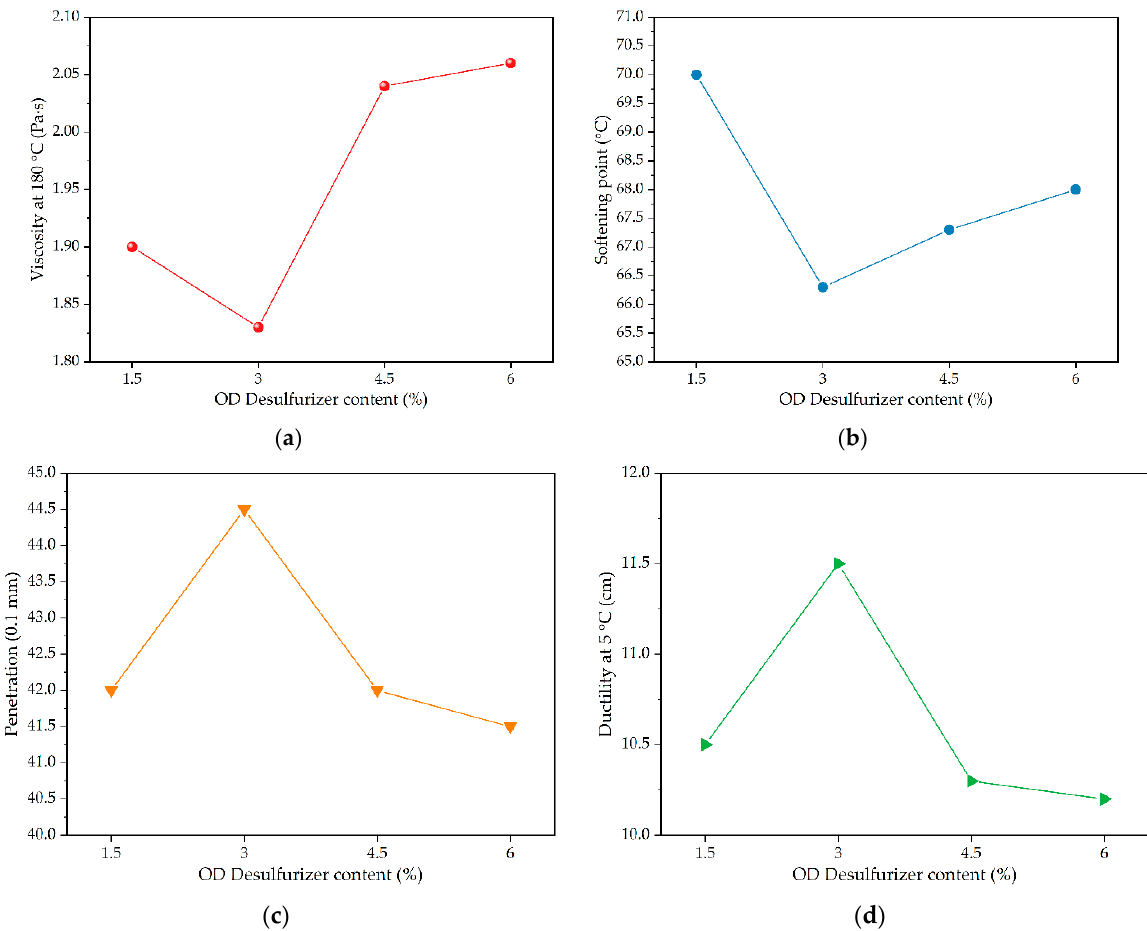
Figure 3. The physical properties of asphalt modified by crumb rubber treated with different OD desulfurizer contents: ( a ) viscosity at 180 °C; ( b ) softening point; ( c ) penetration; ( d ) ductility at 5 desulfurizer contents: ( a ) viscosity at 180 ◦ C; ( b ) softening point; ( c ) penetration; ( d ) ductility at 5 ◦ °C.